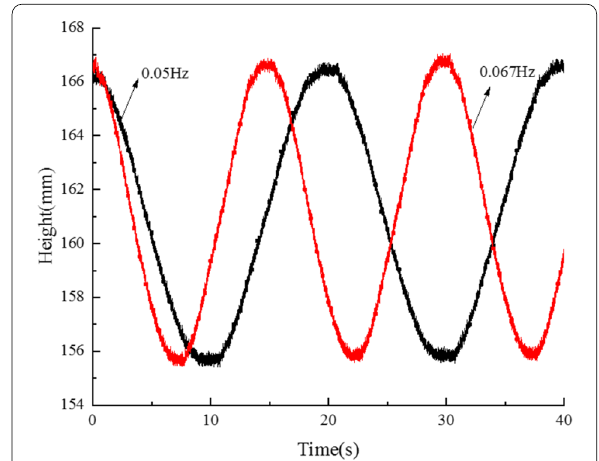
Figure 31 Changes in height at different